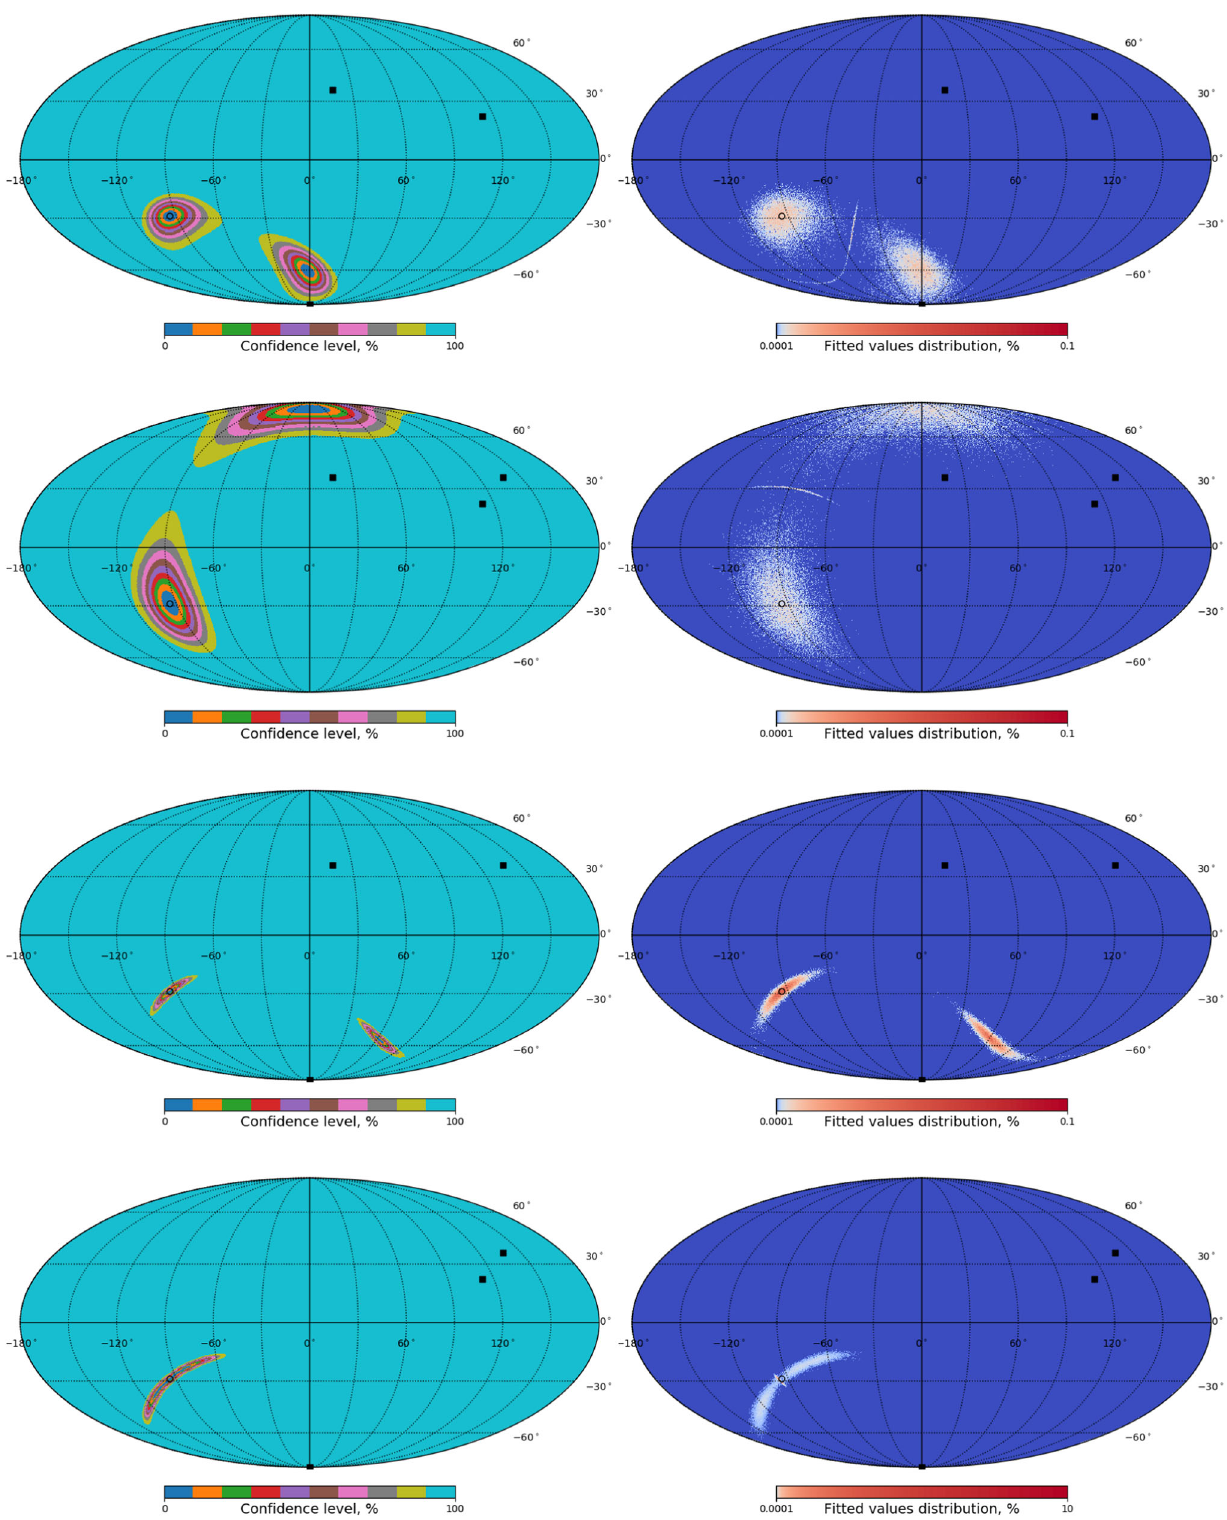
Fig. 4 Mollweide projection of the confidence areas assuming true delays (left) and fitted position distributions over 100,000 realisa- tions (right) in equatorial coordinates for a CCSN at the Galactic Centre (black dot) computed using triangulation between different